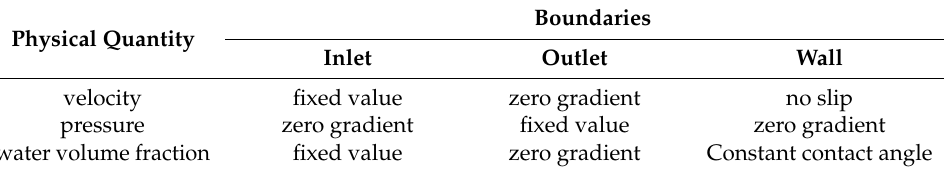
Table 1. Numerical boundary conditions.